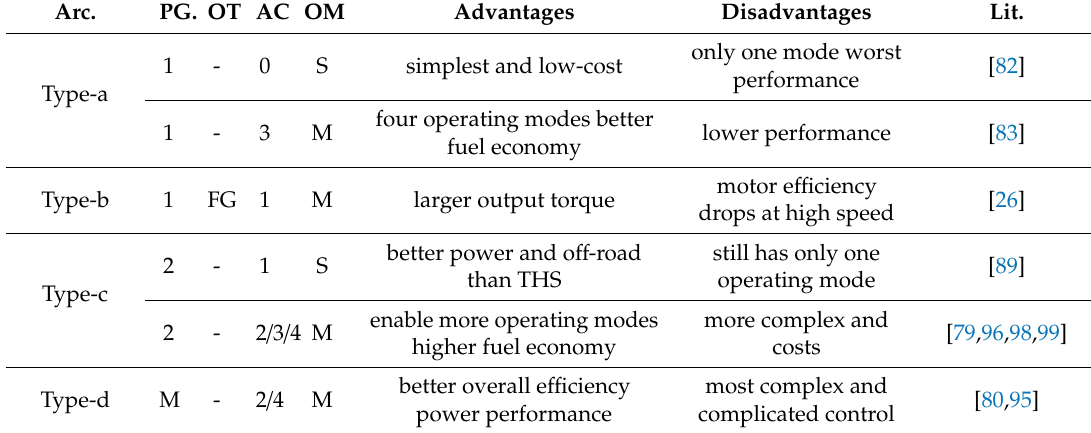
Table 6. The Comparison of four types of two EMs planetary hybrid powertrain system (TEM-PHPS). Arc.